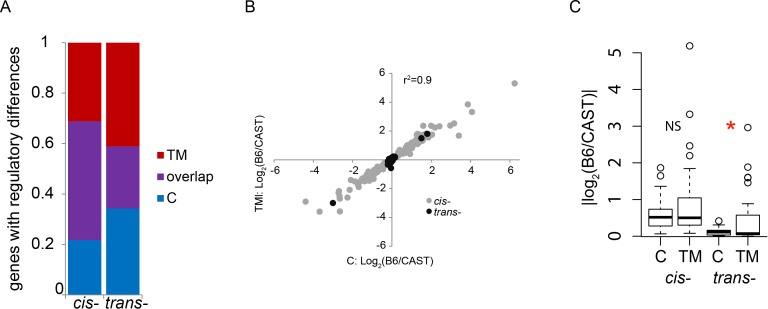
ER stress alters the genes that display regulatory differences between B6 and CAST.(A) Distribution of genes showing cis- or trans-regulatory differences found only under TM conditions, found only under control conditions, or found in both conditions. (B) Genes that show the same cis- or trans-regulatory difference under both conditions (‘purple’ genes in A) are strongly correlated in their magnitude. ER stress does not affect regulation of these genes. (C) Magnitude of the cis- or trans-regulatory differences unique to control or TM conditions. Magnitude of cis-regulatory differences unique to either condition is unaffected by ER stress. trans-regulatory differences unique to TM conditions show a small but significantly larger magnitude than trans-regulatory differences unique to control conditions (*, p < 0.05). NS: not significant; C: control; TM: tunicamycin.